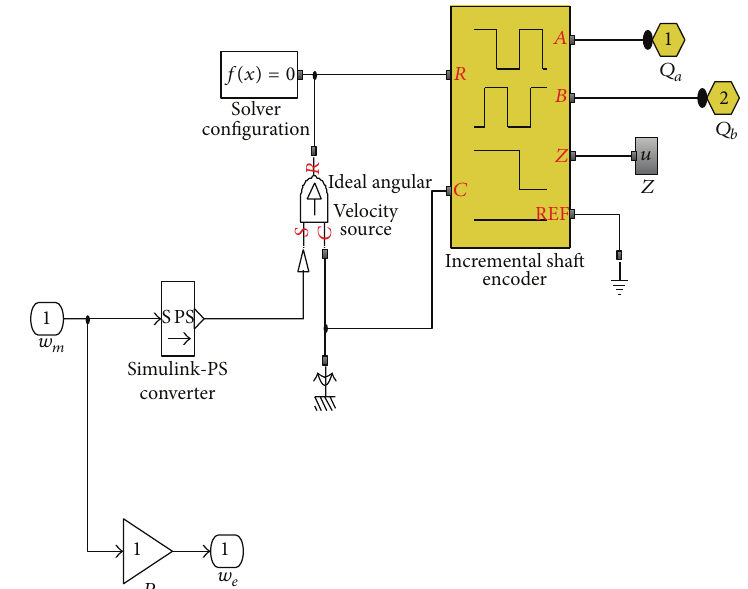
Figure 3: Inverter model for BLDC motor drive.